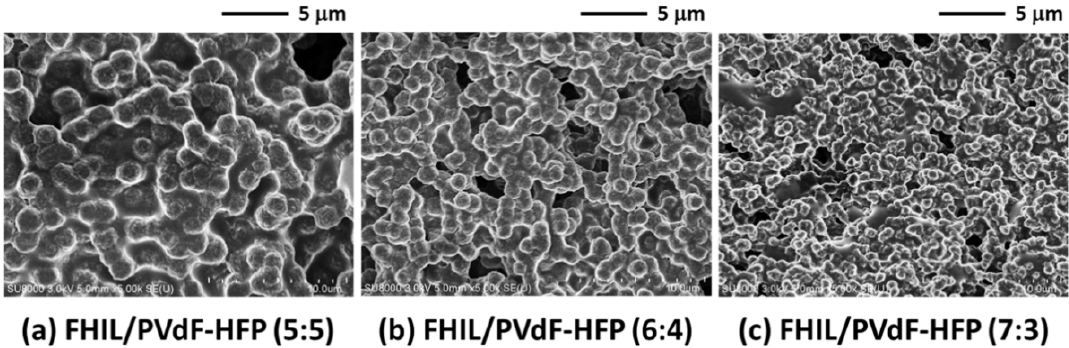
Figure 5. SEM images of EMPyr(FH) 1.7 F/PVdF-HFP composite membranes with the FHIL:polymer weight ratio of ( a ) 7:3; ( b ) 6:4; and ( c )